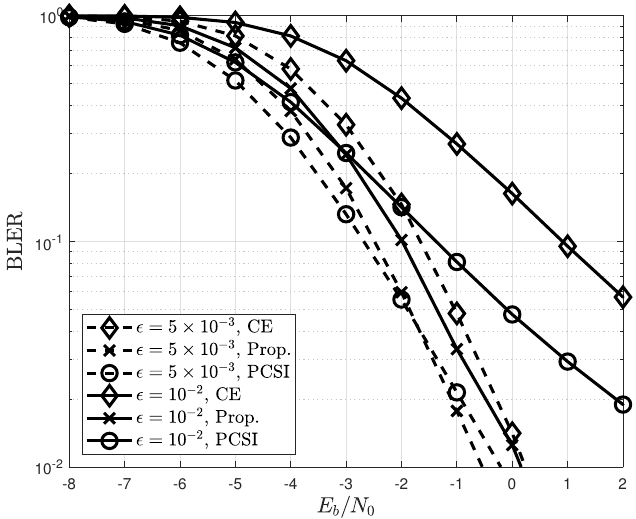
Figure 10. BLERs of the proposed channel estimators in time-varying